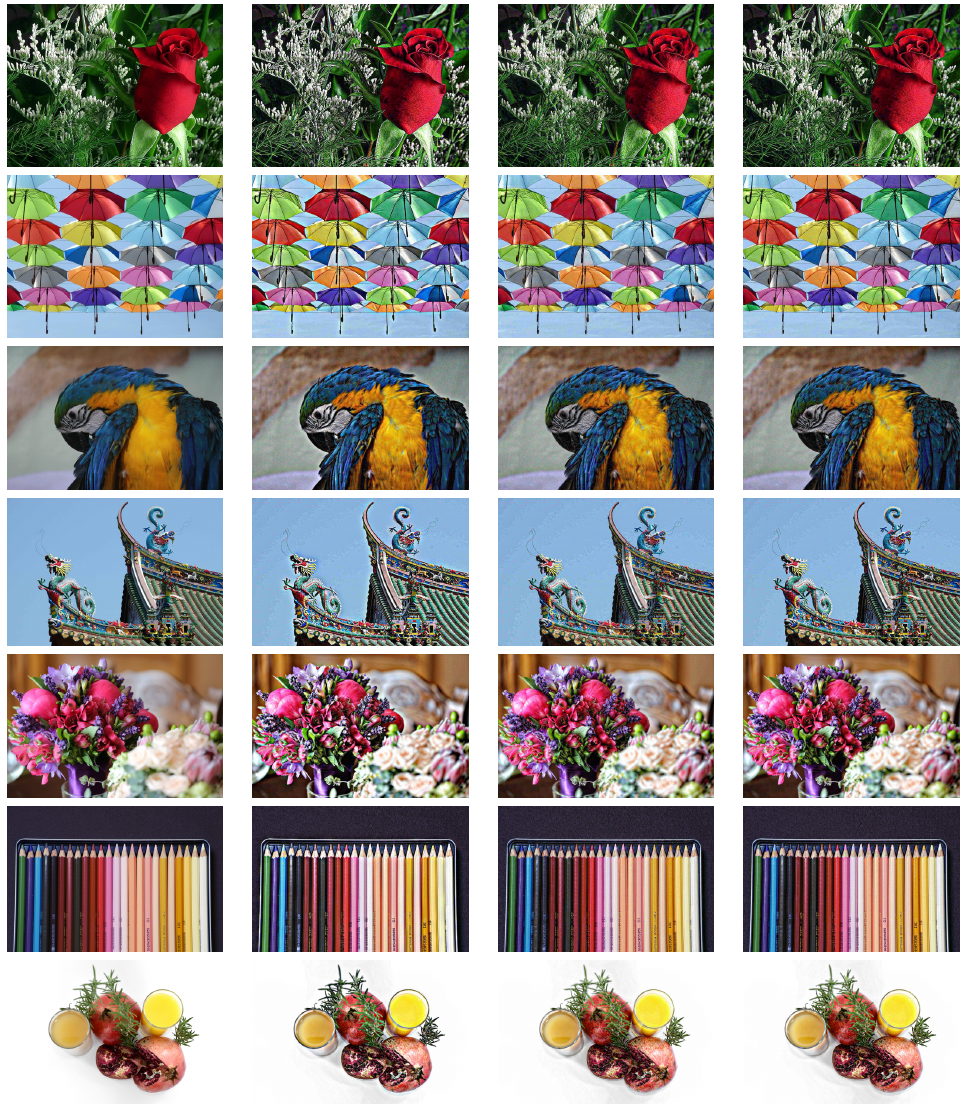
Figure 4. Example results for gamma contrast enhancement with γ = 0.7. Original images in the first column, Poisson solution in the second, ad hoc anisotropic diffusion with K = 10 − 3 in the third, and the proposed variational with K = 0.3 × 10 − 4 in the fourth. All images are available under the CC0